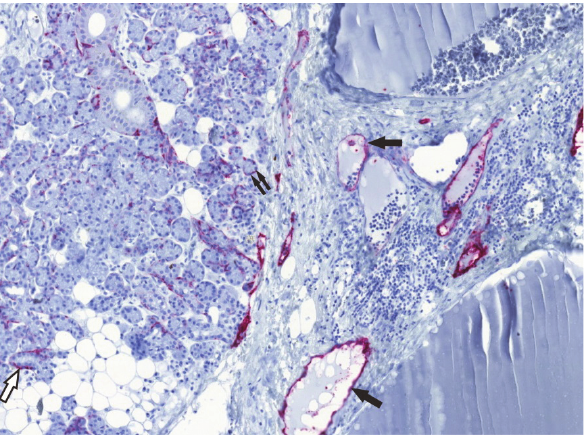
Fig. 2. Warthin’s tumour. Mostly compressed D2-40 positive lymphatic vessels are seen in the lymphoid stroma (black arrows). Positive immunoreaction reveal also follicular dendritic cells in the germinal center (as- terisk) and basal cell of the epithelial component (white arrow).